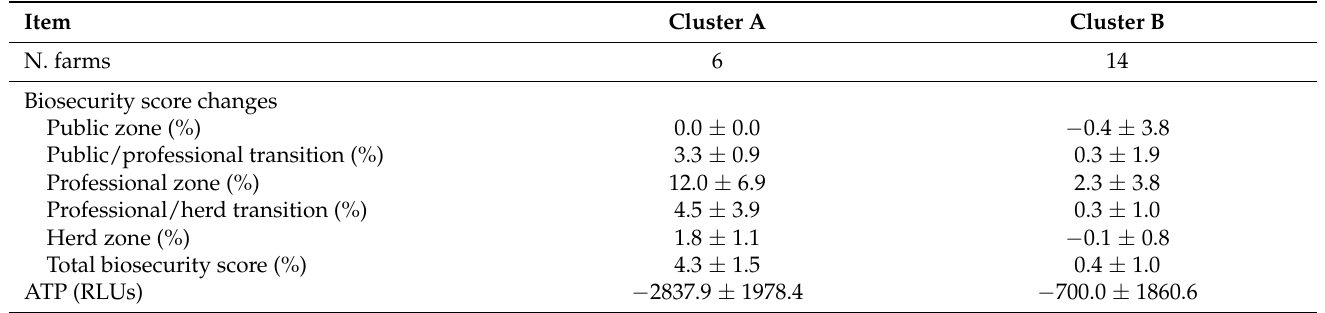
Table 2. Changes in biosecurity scores after 12 months and ATP level evolution in the two clusters identified with the HCA. All the variables showed a squared cosine > 0.2. RLUs = relative-light units.